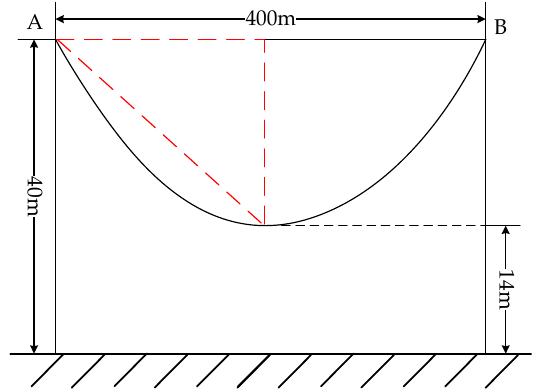
Figure 1. Simplified computational model of a transmission line.